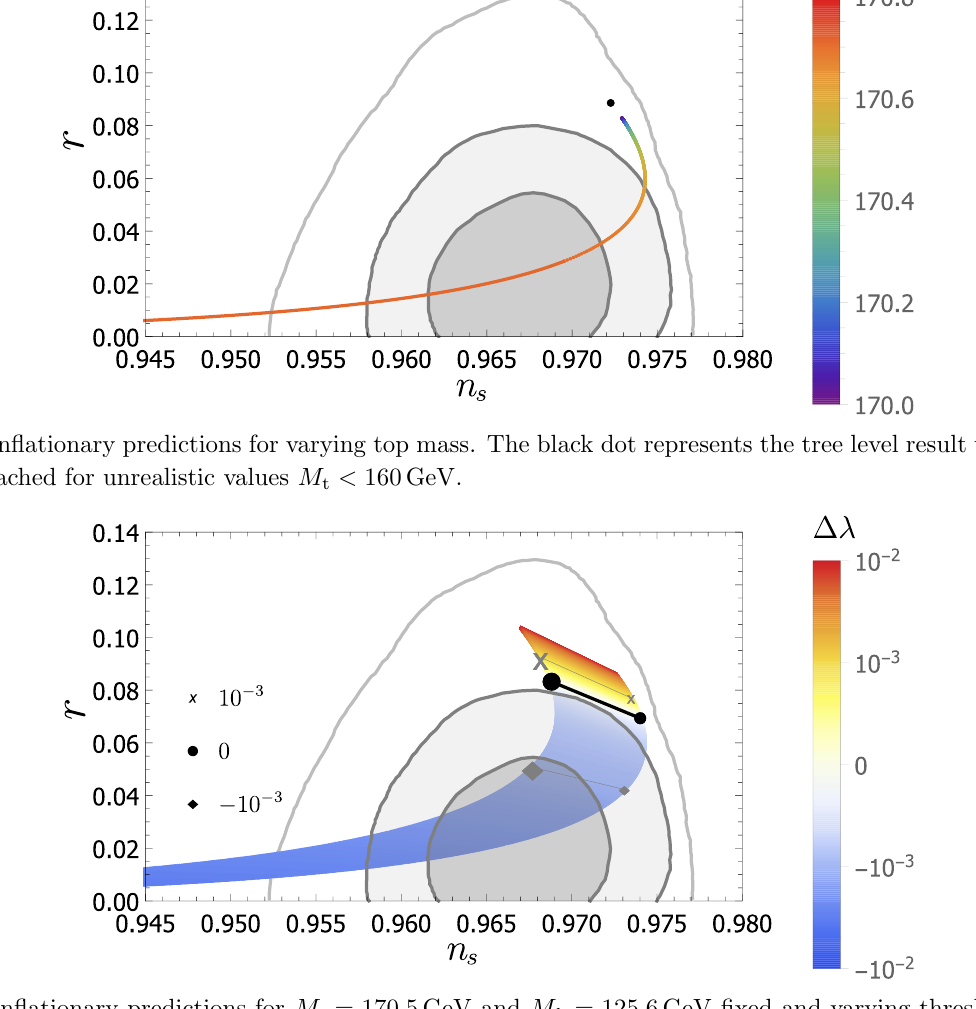
(b) In(cid:13)ationary predictions for M t = 170 : 5 GeV and M h = 125 : 6 GeV (cid:12)xed and varying threshold conditions. The cross, circle, and diamand markers correspond to (cid:1) (cid:21) = 10 (cid:0) 3 ; 0 and 10 3 respec- tively. Results are shown for the range N (cid:3) = 50 (big marker) to N (cid:3) = 60 (small marker). Note that, in agreement with (cid:12)gure 2b, negative kicks lead to a bigger spread in the predictions. Figure 4 . Case A: predictions for the spectral index n s and tensor-to-scalar ratio r compared to the 2018 (1 and 2 (cid:27) in the grey shaded regions) and the 2015 Planck data (the external light grey line is the 2 (cid:27) contour). The e(cid:11)ect of threshold corrections is completely degenerate with changing EW boundary